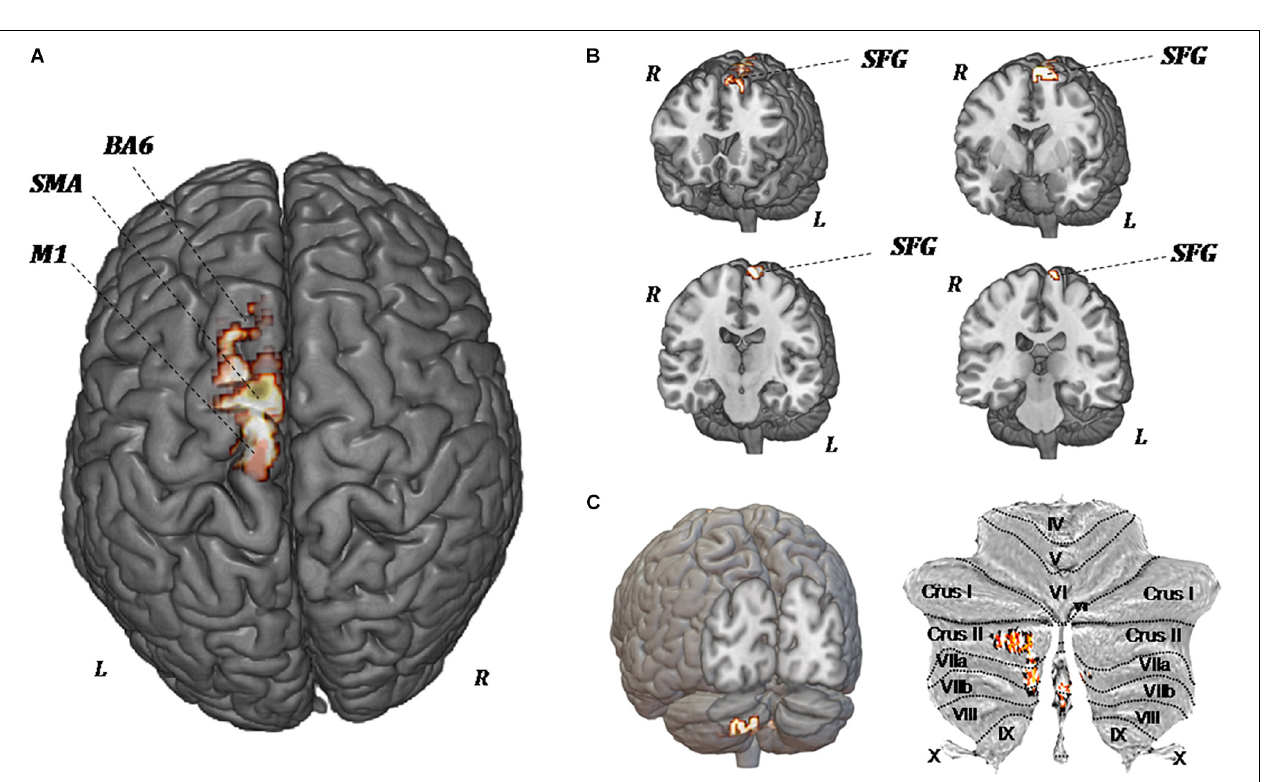
FIGURE 5 | MR perfusion maps demonstrate pre-forced exercise vs. post-forced exercise cerebral blood (CBF) flow changes. The red areas, overlaid on anatomical volumetric T1-weighted images axial (A) and coronal views (B,C) , represent the voxels with a statistical significant CBF augmentation: the left superior frontal gyrus and left cerebellar hemisphere. Comparing the CBF values of each voxels between pretreatment and posttreatment, in all patients, the increased CBF areas are observed in the left supplementary motor area (SMA), left premotor area (BA6), primary motor area (M1), and left cerebellum (crus II, VIIa, and VIIb).